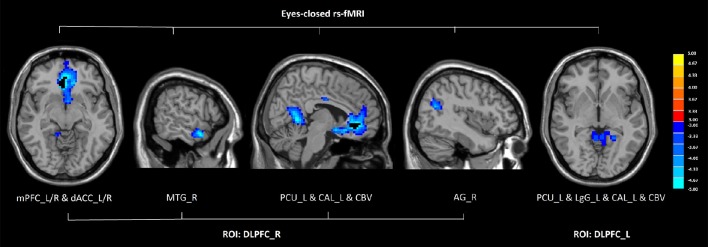
Altered functional connectivity seeded from the bilateral DLPFC in GAD, compared with HC (P < 0.005 to define cluster, AlphaSim correction, cluster size >53 voxels, overall p < 0.05). Hot and cold colors indicate increased and decreased FC in GAD compared with HC. (DLPFC, dorsolateral prefrontal cortex; GAD, generalized anxiety disorder; HC, healthy control; rs-fMRI, resting state fMRI; mPFC, medial prefrontal cortex; dACC, dorsal anterior cingulate cortex; MTG, middle temporal gyrus; PCU, precuneus; CAL, calcarine sulcus; CBV, cerebellar vermis; AG, angular gyrus; LgG, lingual gyrus; L, left; R, right).